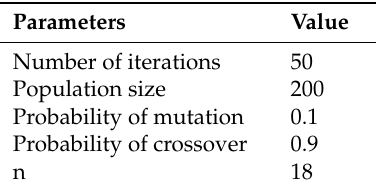
Table 5. Parameters of